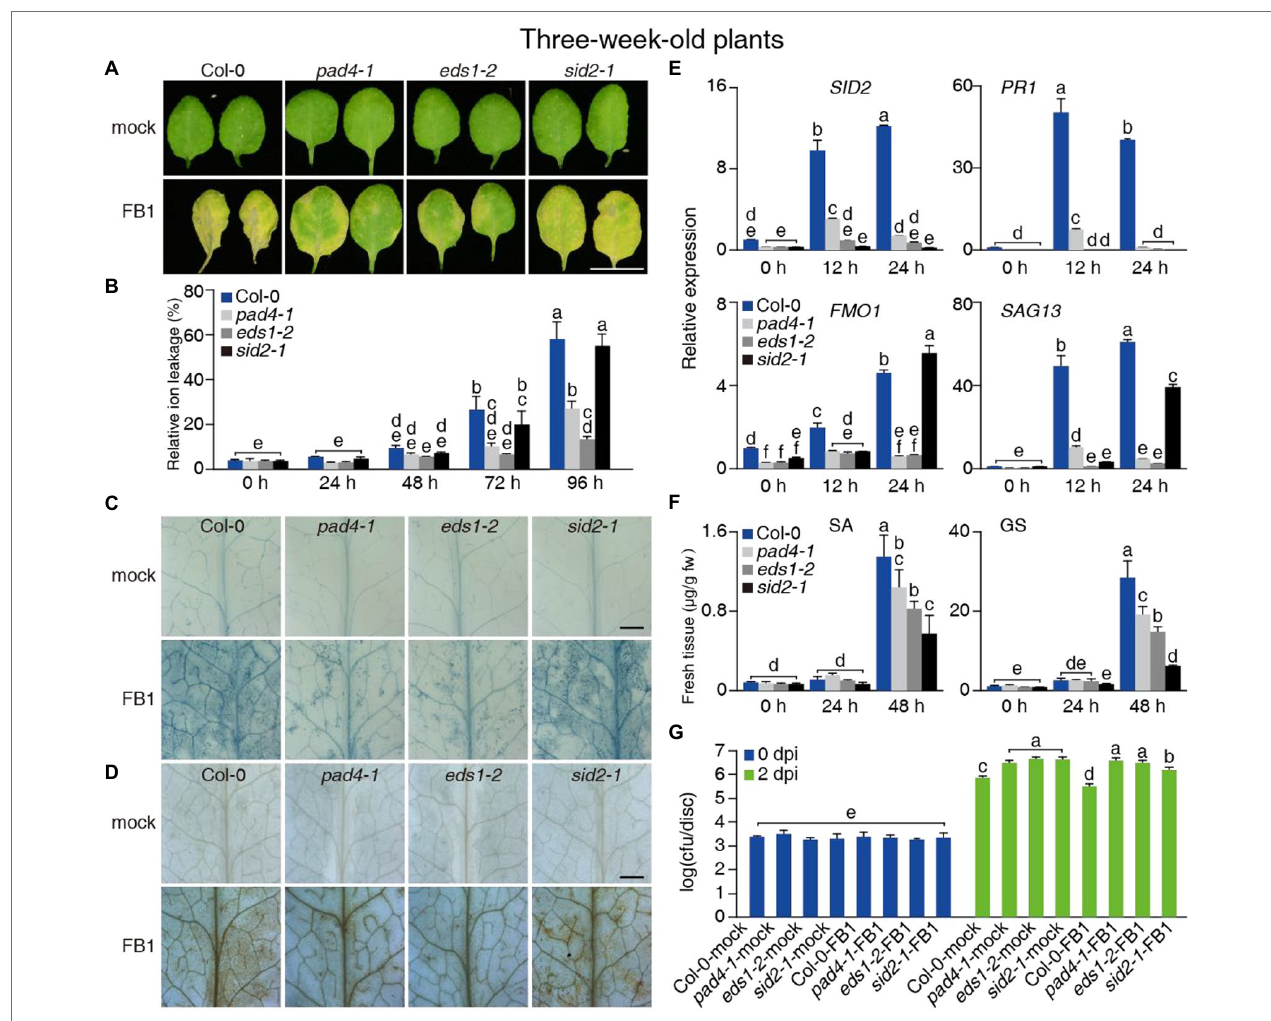
FIGURE 2 | Effect of the pad4-1 , eds1-2 , and sid2-1 mutations on FB1-triggered cell death and resistance to Psm DG3. (A–F) Three-week-old Col-0, pad4-1 , eds1-2 , and sid2-1 plants were treated with mock or 10 μ M FB1. (A) Representative images of detached leaves 4 days after treatment. Bar = 1 cm. (B) Relative ion leakage detection of plants 24–96 h after treatments. (C,D) Trypan blue (C) and DAB (D) staining of plants 3 days after treatments. Bars in (C,D) = 1 mm. (E) Relative transcript levels for SID2 , PR1 , FMO1 , and SAG13 in plants 12 and 24 h after 10 μ M FB1 treatments. ACT2 served as internal control. Values were normalized to Col-0 levels (set to 1). (F) Free SA and GS levels in plants 24 and 48 h after 10 μ M FB1 treatments. (G) Growth of Psm DG3 in FB1-treated plants 2 dpi. The plants were sprayed with 0.5 mM FB1 1 day before Psm DG3 inoculation. Values are means ± SE from triplicate biological repeats in (B,E,F) , six biological replicates at 0 dpi and 24 biological replicates at 2 dpi in (G) . Different letters indicate significant differences assessed among all genotypes/time points, as determined by Fisher’s PLSD ( p < 0.05; B,E–G ). At least 30 plants per line were tested each time in (A,B,G) , at least 12 leaves per line were stained each time in (C,D) . All experiments were conducted at least three times